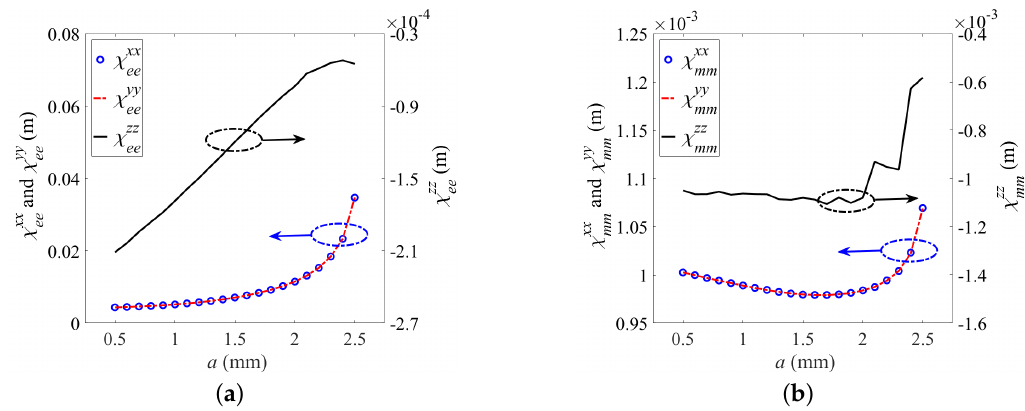
Figure 12. Surface susceptibilities of the unit cell shown in Figure 11 at 10 GHz: ( a ) χ ee , ( b ) χ mm .